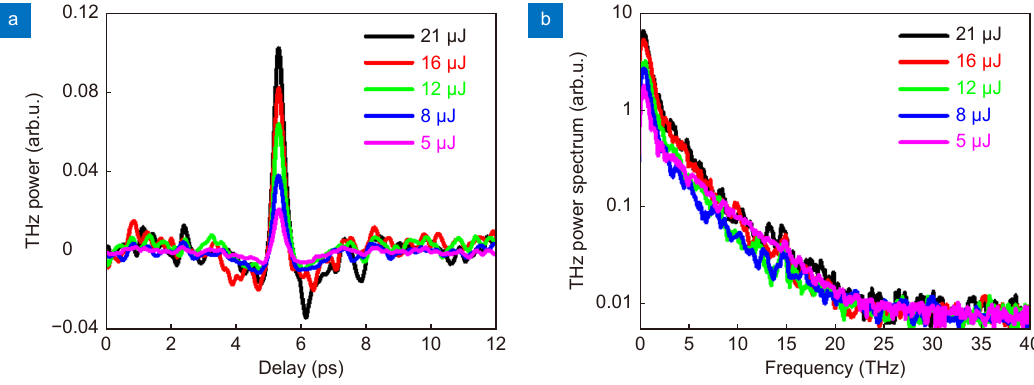
Fig. 4 | ( a ) Autocorrelation traces and ( b ) spectra of various energy THz pulses in argon.